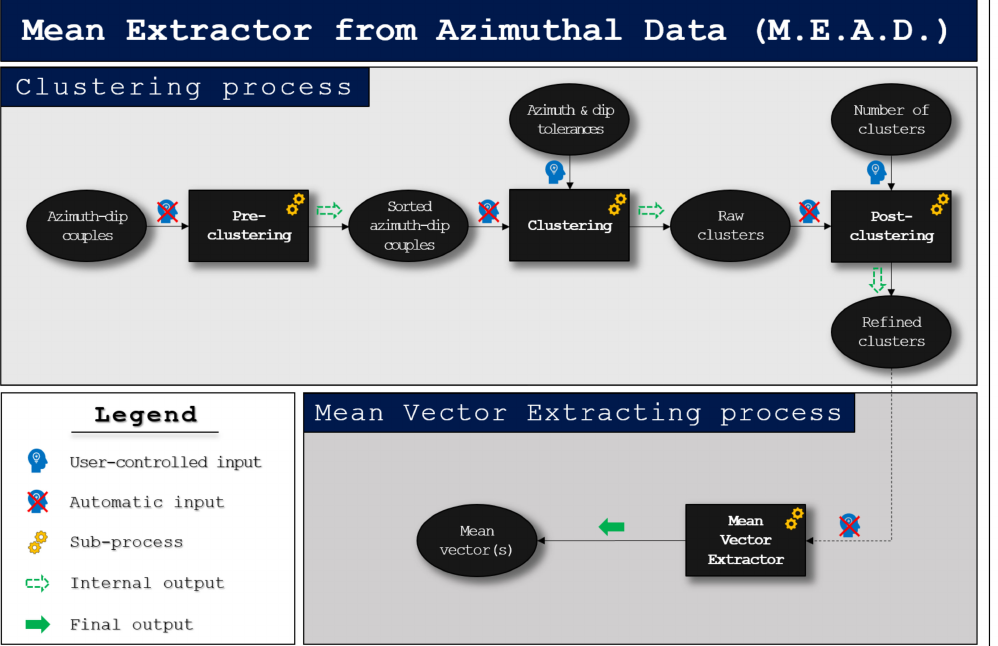
Figure 4. Mean Extractor from Azimuthal Data (M.E.A.D.) algorithm flow chart. Ovals indicate input/output objects, squares indicate algorithm subprocesses. The azimuth-dip couples are first sorted by most frequent azimuth value (pre- clustering); then the clustering subprocess is applied, taking care of the user-controlled tolerance parameters. The raw output is then refined in a post-clustering phase and the required number of clusters is returned. Finally, these are fed into the mean vector extracting process that outputs the final result, consisting of one or more mean